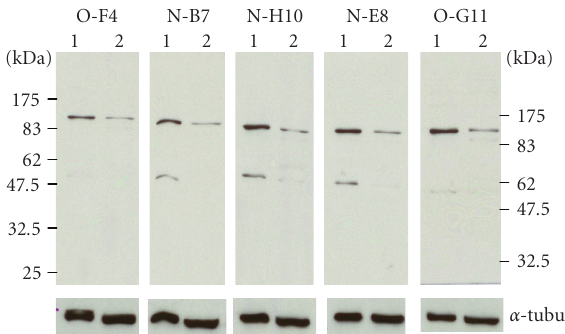
Figure 3: Detection of osteosarcoma antigens by selected Fabs. A western blot using five selected purified Fabs was performed. Protein extracts from U2-OS cells (lane 1) and normal human fibroblasts (lane 2) were transferred to nitrocellulose membranes. The membranes were probed with the O-F4, N-H7, N-H10, N-E8, and O-G11 Fabs. For loading comparison, an anti-alpha tubulin antibody was also used.